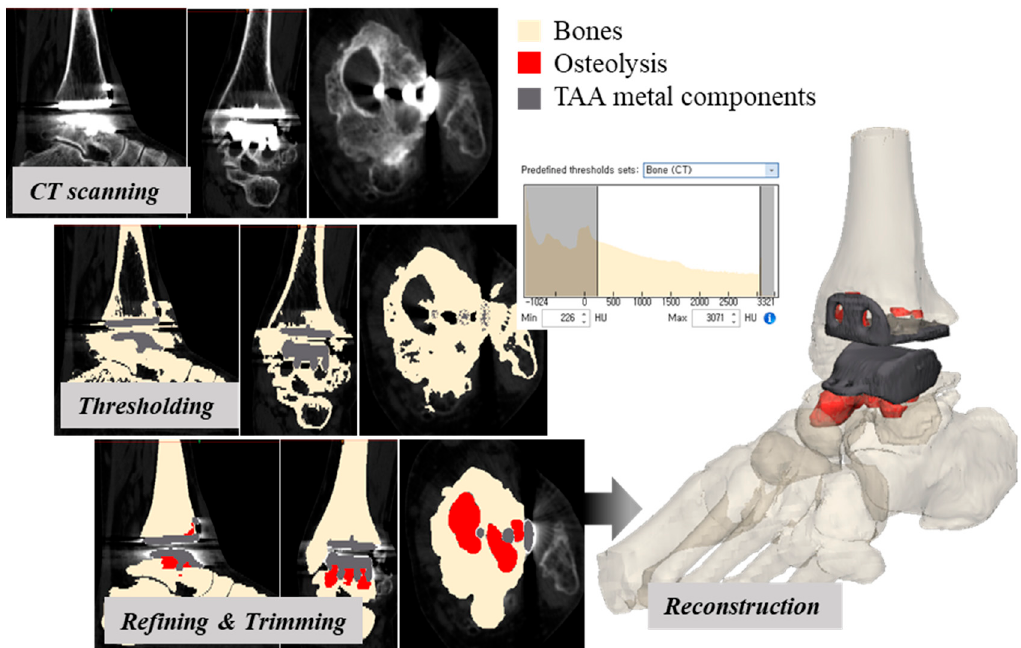
Figure 1. A 3D-CT reconstruction of the post-TAA ankle joint (red, gray, and light yellow indicate osteolysis, TAA metal components, and bones, respectively).